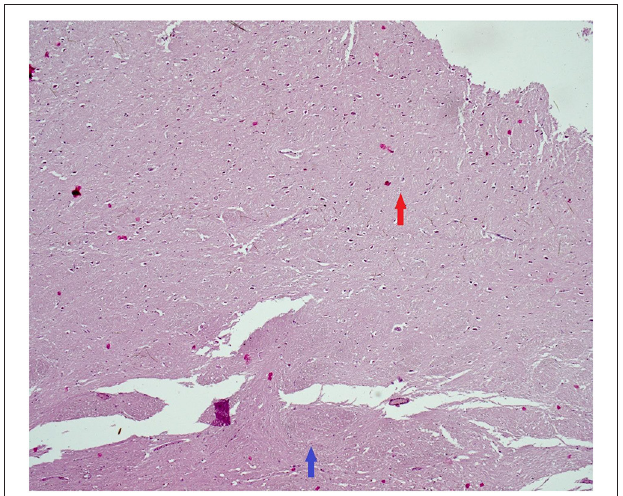
FIGURE 3 | Histopathological findings (tumefactive lesion in the left occipital lobe). Hematoxylin–eosin. Red arrow: plaque with loosing of neuropil and reactive gliosis. Blue arrow: normal myelinated CNS tissue (50 × magnification). CNS, central nervous system.